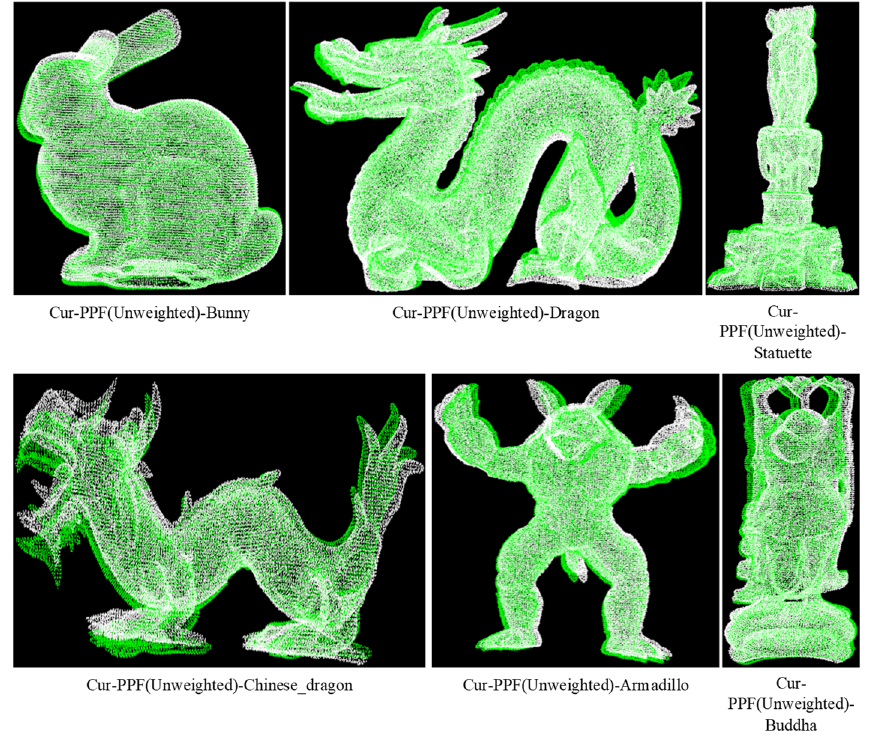
Figure 11. The Cur-PPF(Unweighted) algorithm is used to register the six kinds of point cloud models of the data set. The pose results are used to convert the point cloud of the models into scene space, and the color is used for rendering, where white represents the point cloud of the scene, and green represents the converted model point cloud. Table 1. The matching rate of PPF and Cur-PPF(Unweight) algorithms on public data set. Models